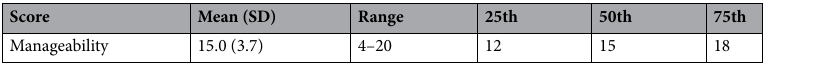
Table 4. Mean, standard deviation and quartiles of the Manageability score based on